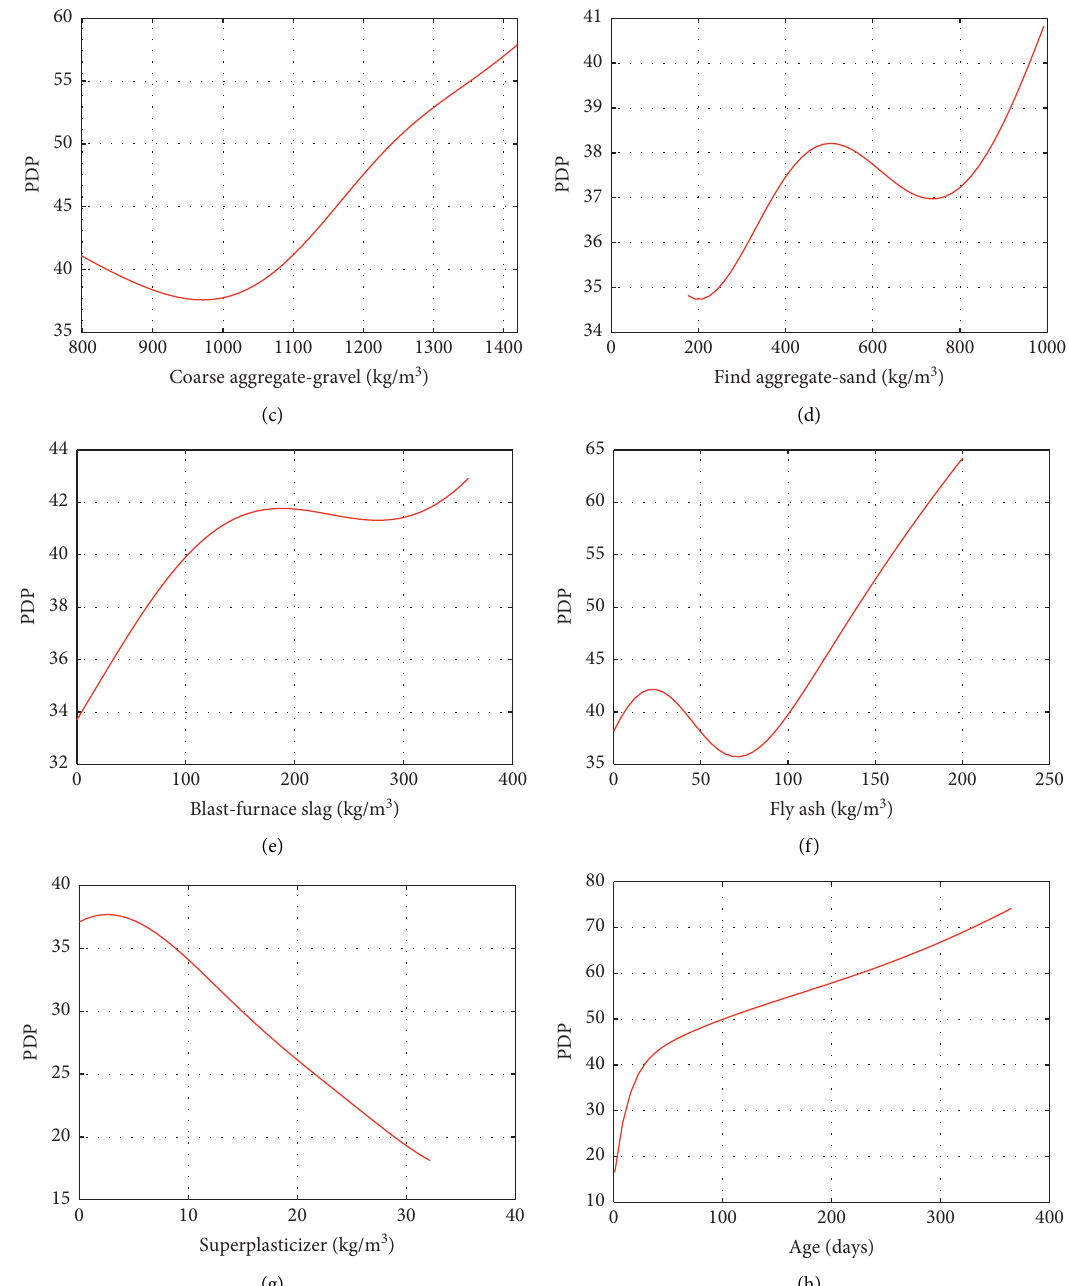
Figure 10: Partial dependence plots (PDP) of the input